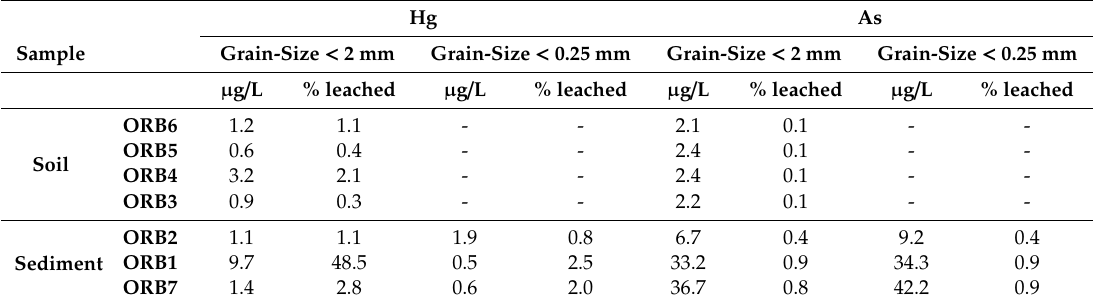
Figure 9. Vertical distribution of Hg and As in the fraction <2 mm. The vertical lines connect the samples of Section A. Dashed horizontal lines indicatesthe different lithological units (abbreviation on the right). The main features of each single unit are summarized in Figure 4 and described in Section 3.1. LU4 (between LU5 and LU3) was not sampled. Table 5. Concentrations ( μ g/L) of Hg and As determined in the leached samples. “% leached” refers to the amount of leached element respect to the total concentration measured in the bulk and reported in Table 4.